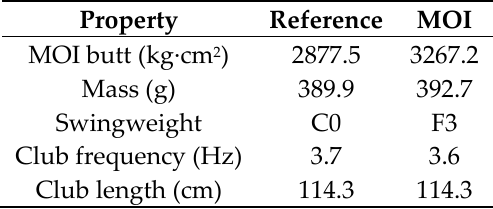
Table 1. Physical properties of the two club conditions used in the study. Values stated include the contribution of the passive markers used for tracking the club during the swing.